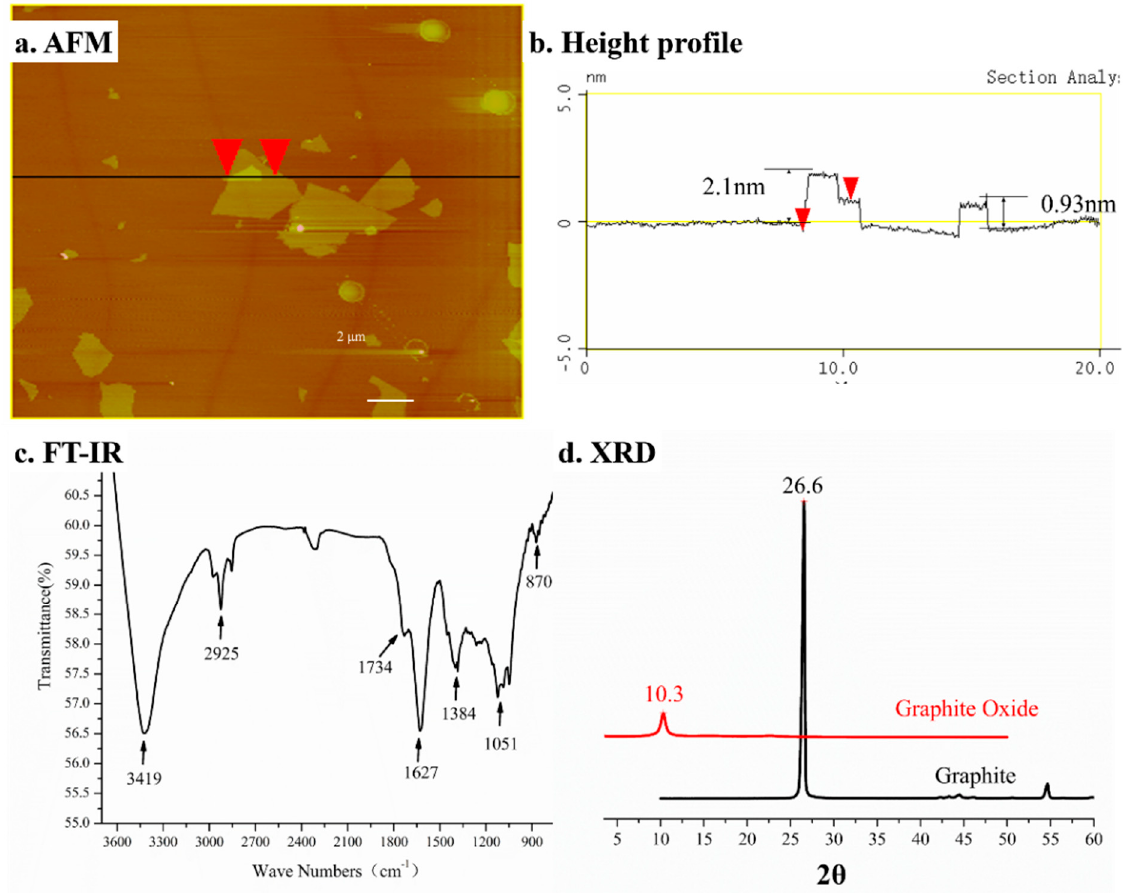
Figure 3. Characterization of GO. ( a ) AFM tapping mode image, ( b ) height profile, ( c ) FT-IR, and ( d ) XRD of GO.